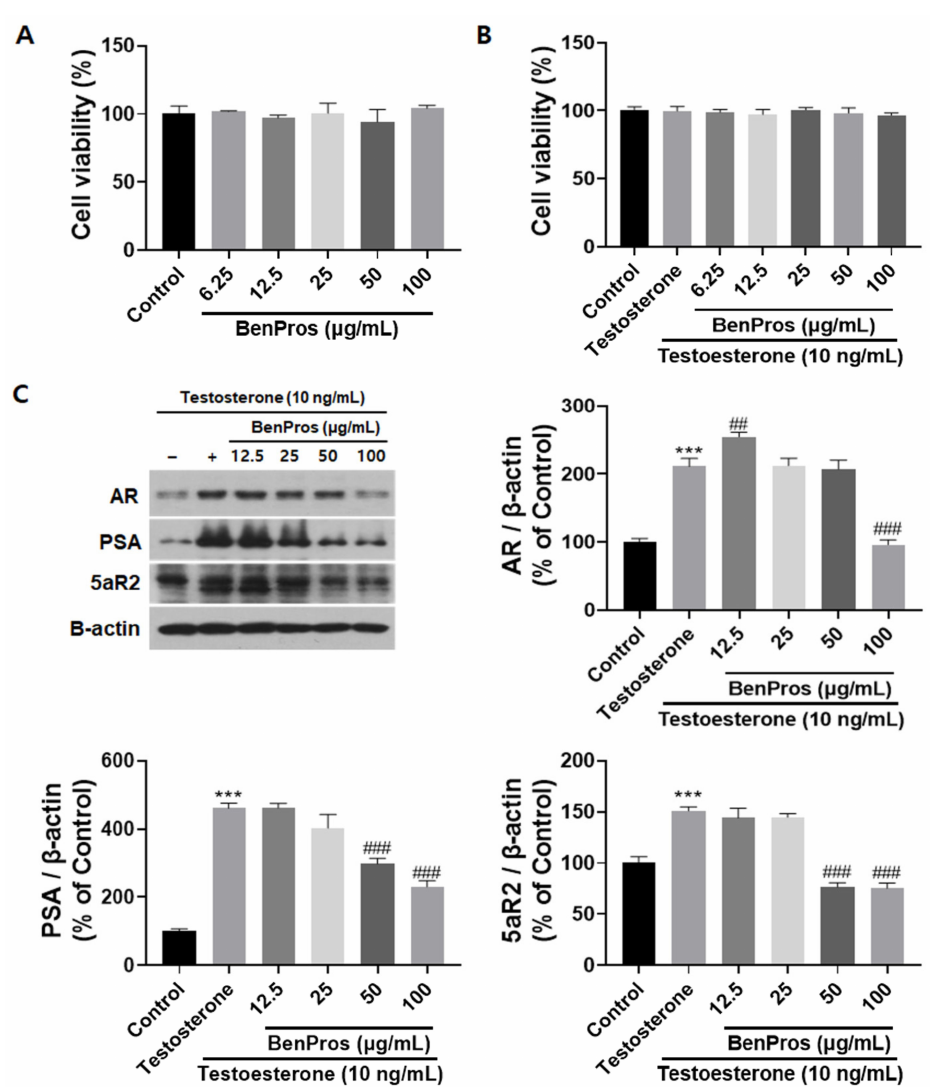
Figure 1. Effect of BenPros on cell viability and the expression of BPH regulators in LNCap-LN3 cells. ( A ) Cell viability of LNCap-LN3 cells treated with BenPros in the absence of testosterone treatment. ( B ) Cell viability in testosterone-treated LNCap-LN3 cells. ( C ) Representative western blots of androgen receptor (AR), prostate-specific antigen (PSA) and 5 α -reductase type 2. Cells were pre-treated with BenPros in the presence of various concentrations for 30 min and treated with testosterone (10 ng/mL) for an additional 24 h. β -Actin was used as an internal standard in western blot. Blots are normalized to β -actin. Values are presented as the mean ± standard deviation from three separate experiments. *** p < 0.001 vs. control; ## p < 0.01 and ### p < 0.001 vs.